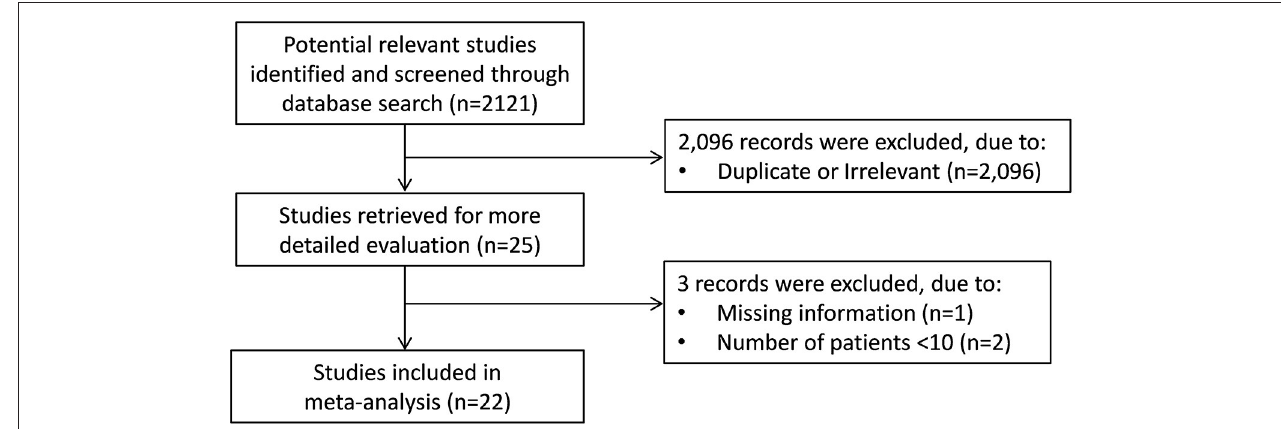
FIGURE 1 | Flow chart of study